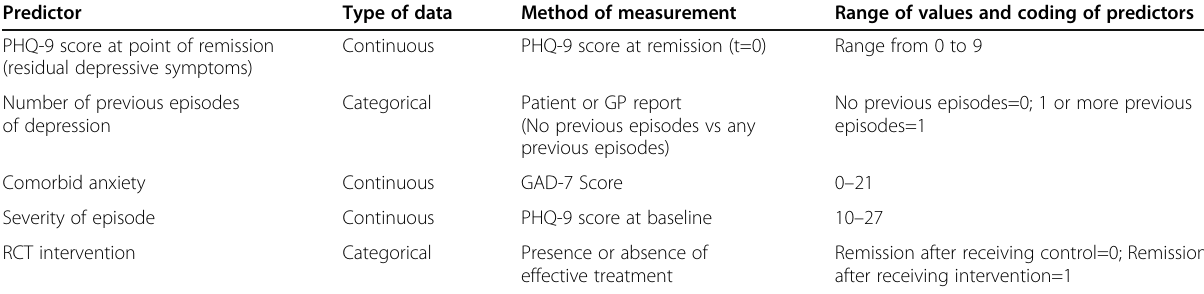
Table 2 Summary of selected predictors Predictor Type of data Method of